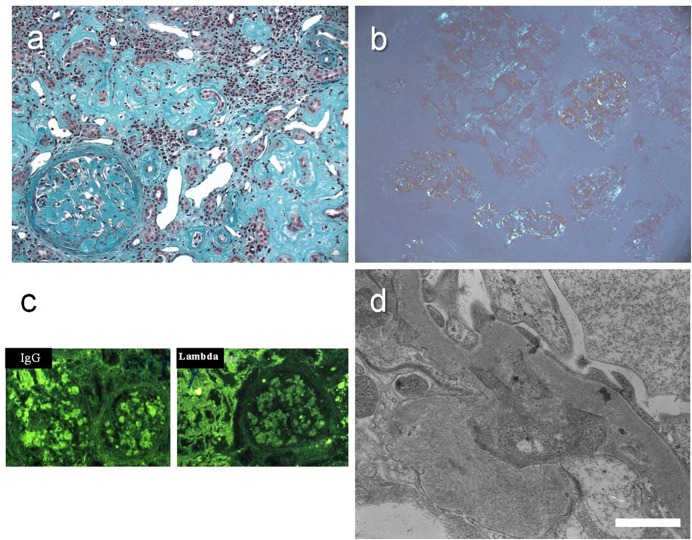
AHL amyloidosis (case 14) (a) Light microscopy.Masson trichrome staining. Massive amorphous deposits in the mesangium and extending to the subendothelial space of glomerular capillaries, Bowman’s capsule, the interstitium, the tubular basement membrane and the arterioles. Original magnification, X 20. (b) Apple green birefringence detected under polarized light. Original magnification, X 20. (c) Immunofluorescence microscopy. Monotypic Ig lambda deposits. Equally intense staining for heavy and light chains. (d) Electron microscopy. Non oriented, randomly arranged, 10-nm diameter fibrils. Bar = 1250 nm.